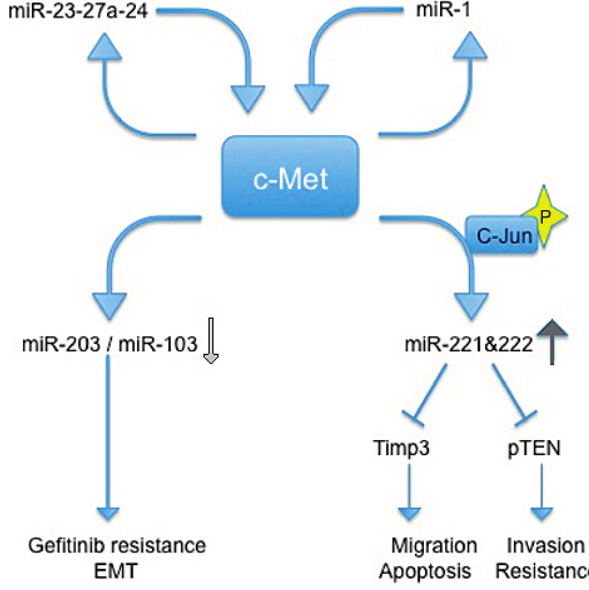
Figure 2. Schematic representation of regulatory circuits controlled by c-Met and miRNAs. Blue arrows indicate an induction of downstream signal trasduction, wherease blue shapes indicate a block of downstream signal trasduction. Light gray arrow indicates a reduction of miRs, the dark gray arrow indicates an increase of